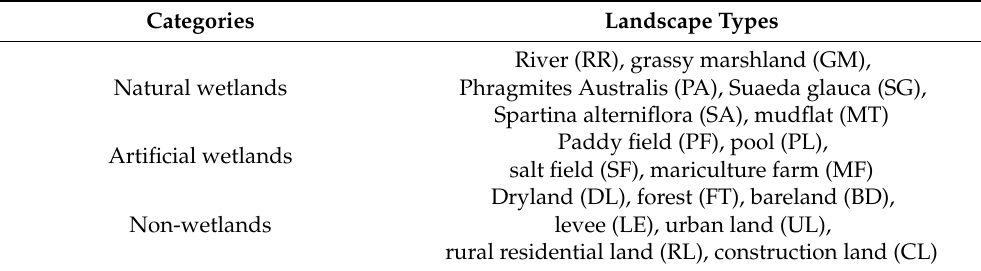
Table 1. Landscape types in Jiangsu coastal wetlands.